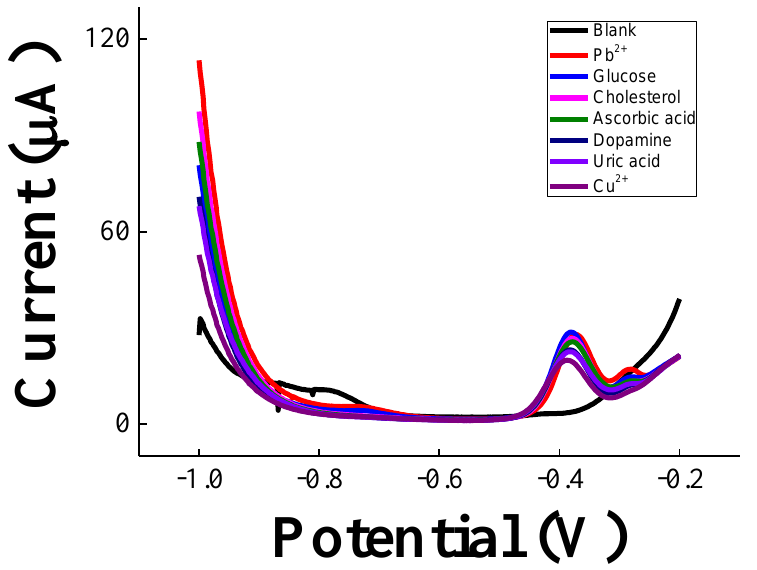
Figure 5. Interferent study with glucose, cholesterol, ascorbic acid, dopamine, and uric acid. The concentration for lead and interferents was 2.5 µM in artificial sweat.